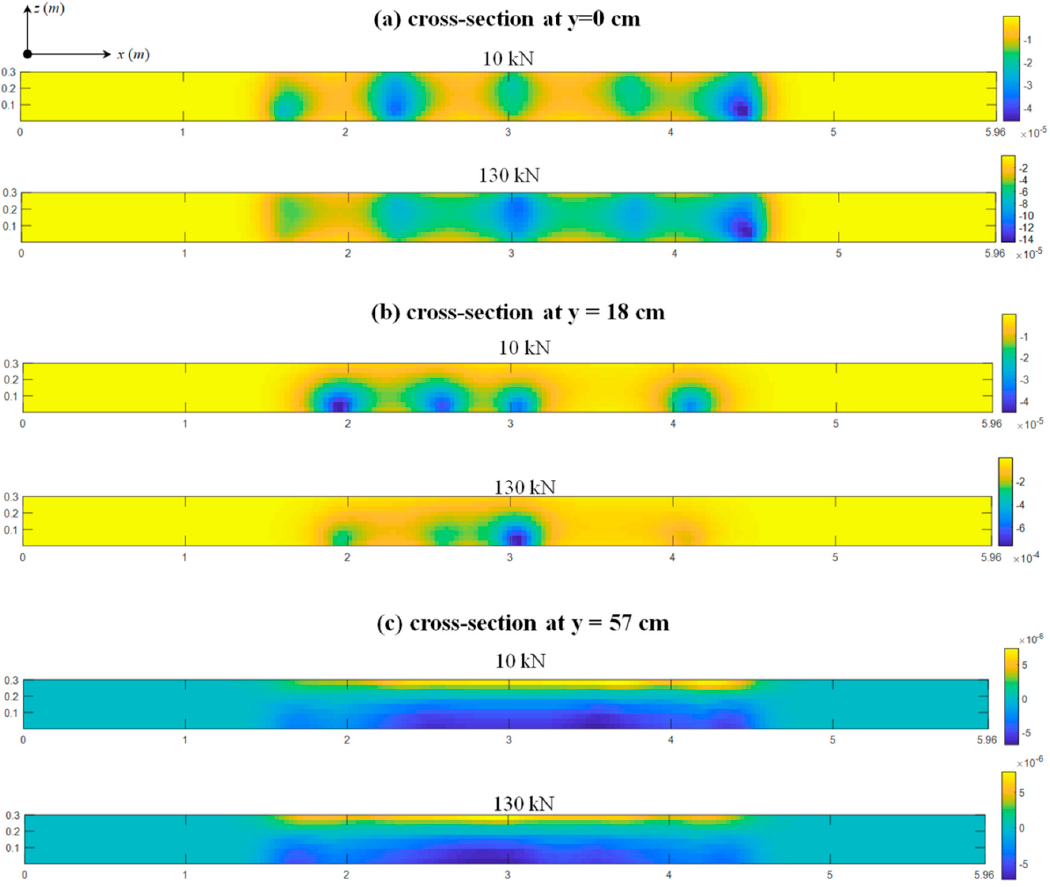
Figure 7. The m(r)-based imaging results under 10 kN and 130 kN at ( a ) y = 0, ( b ) y = 18, and ( c ) y = 57 cm. Figure7. Them(r)-basedimagingresultsunder10kNand130kNat( a )y = 0, ( b )y = 18, and( c )y = 57